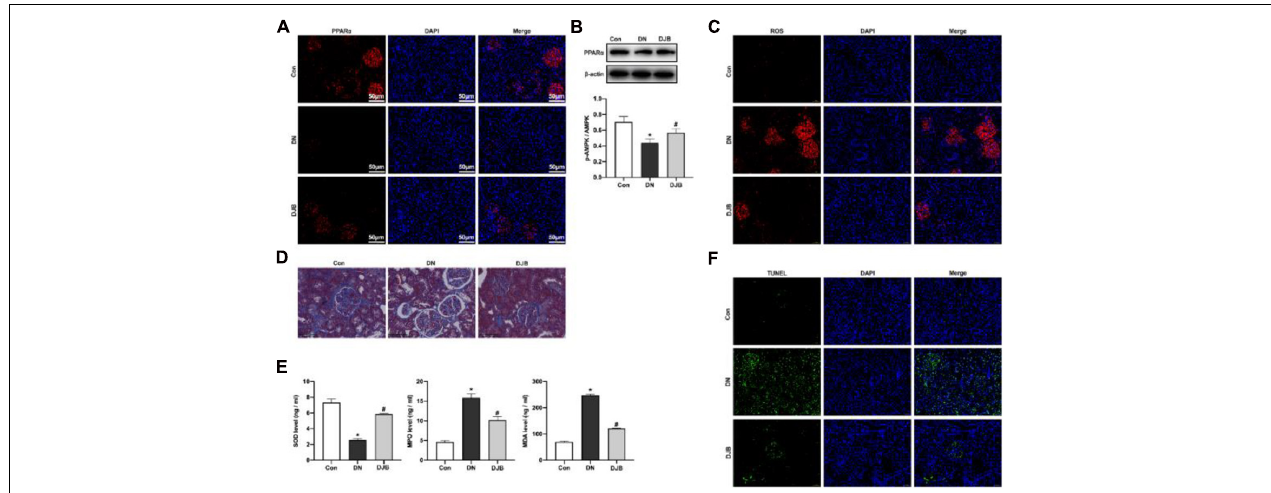
FIGURE 3 | Bariatric surgery inhibited oxidative stress injury through activating PPAR α . The expression of PPAR α was detected by immunofluorescence (IF; scale bar , 50 µ m) (A) and Western blotting (B) . (C) Mitochondrial ROS detected by DHR123 staining ( scale bar , 50 µ m). (D) Fibrosis of the kidney tissues observed with Masson staining ( scale bar , 100 µ m). (E) Quantification of the oxidation-related factors (SOD, MDA, and MPO) in rat serum by ELISA. (F) Renal apoptosis detected by TUNEL staining ( scale bar , 50 µ m). All data represented the mean ± SD. * p < 0.05 [compared with the control (Con) group]; # p < 0.05 [compared with the diabetic nephropathy (DN) group]. ROS, reactive oxygen species; SOD, superoxide dismutase; MDA, malondialdehyde; MPO, myeloperoxidase.